Question: What style of plot is this figure drawn as?
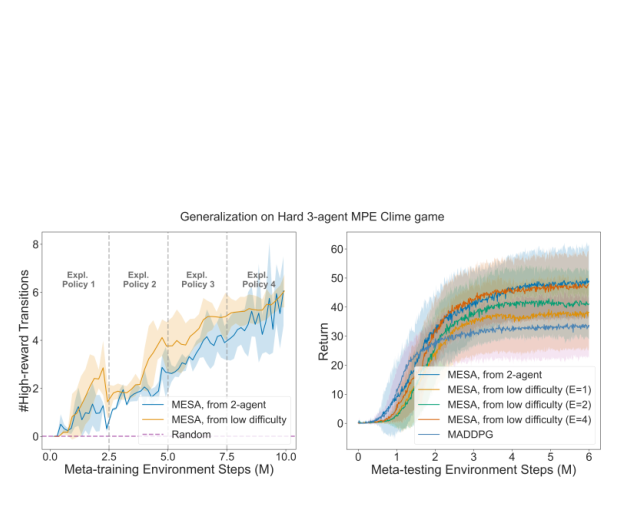
Answer: line